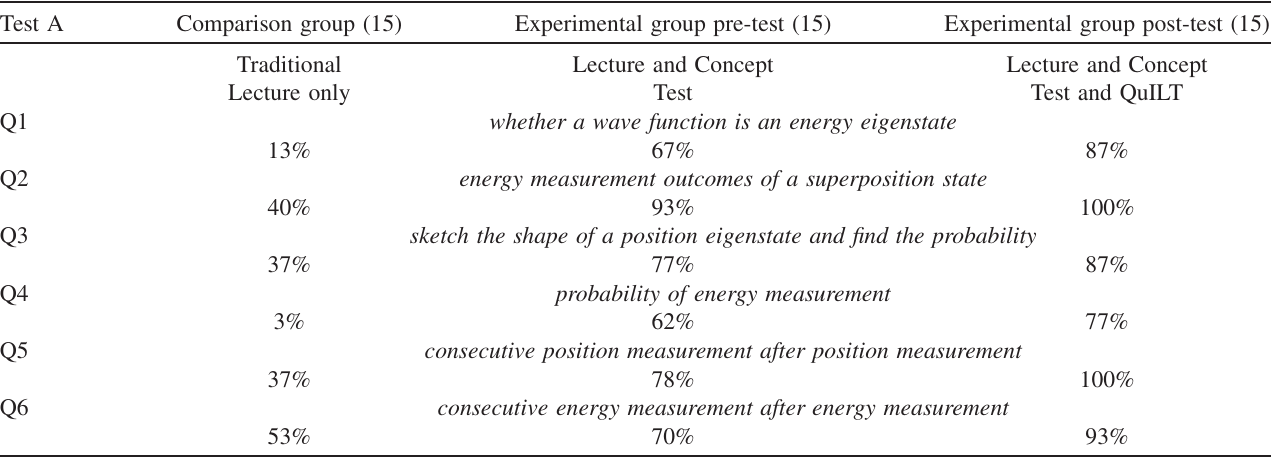
TABLE I. The pre-test and post-test scores on each question of test A. The concepts involved in each question are shown in italic.